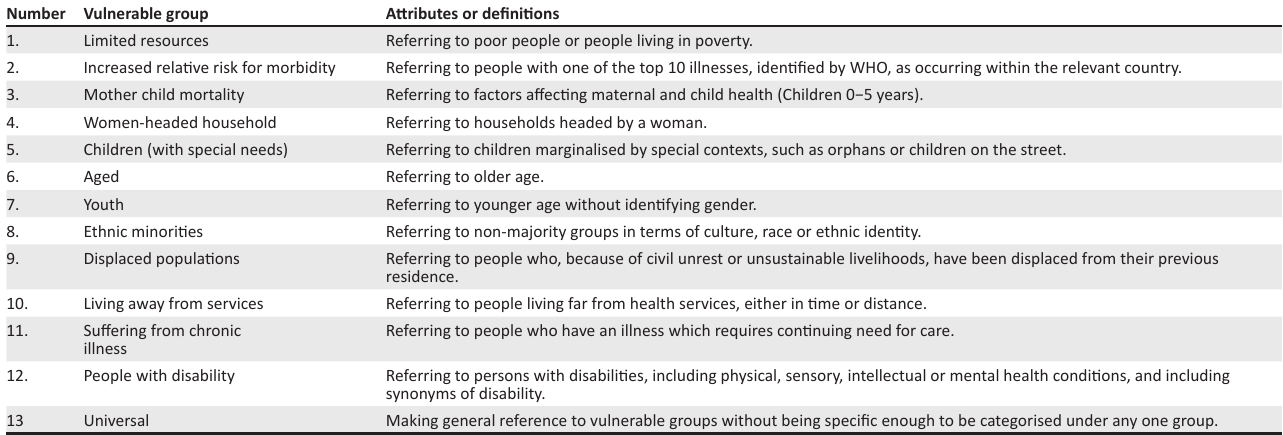
TABLE 2: List and definition of vulnerable